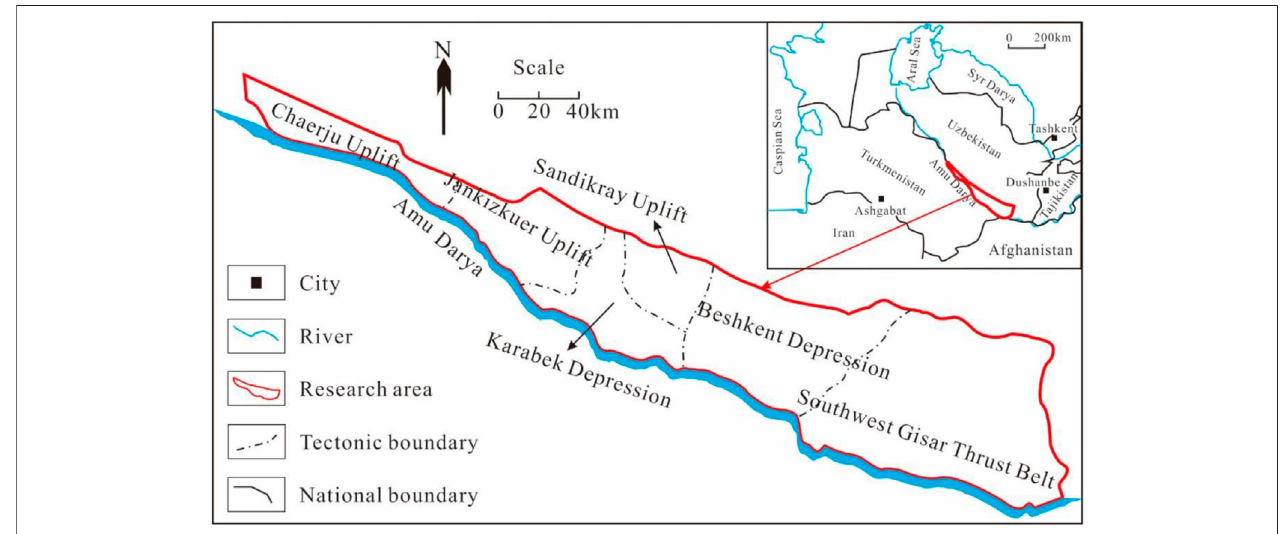
FIGURE 1 | Location of the research area.